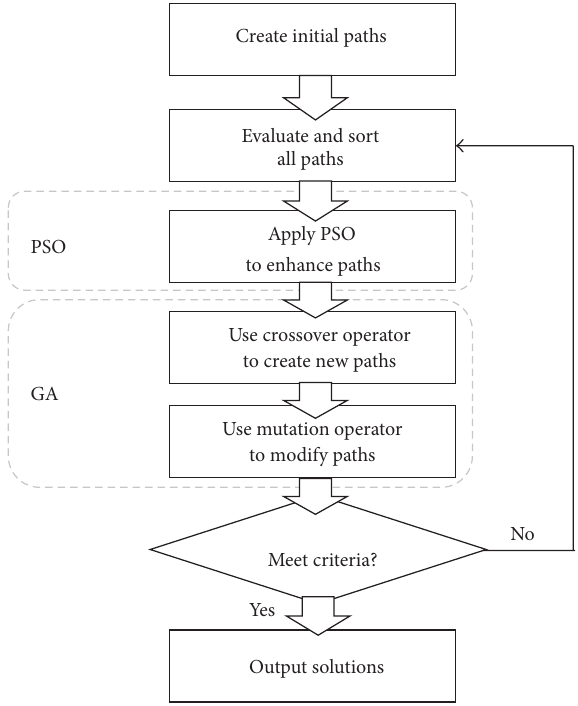
Figure 1: The flowchart of hybrid evolutionary